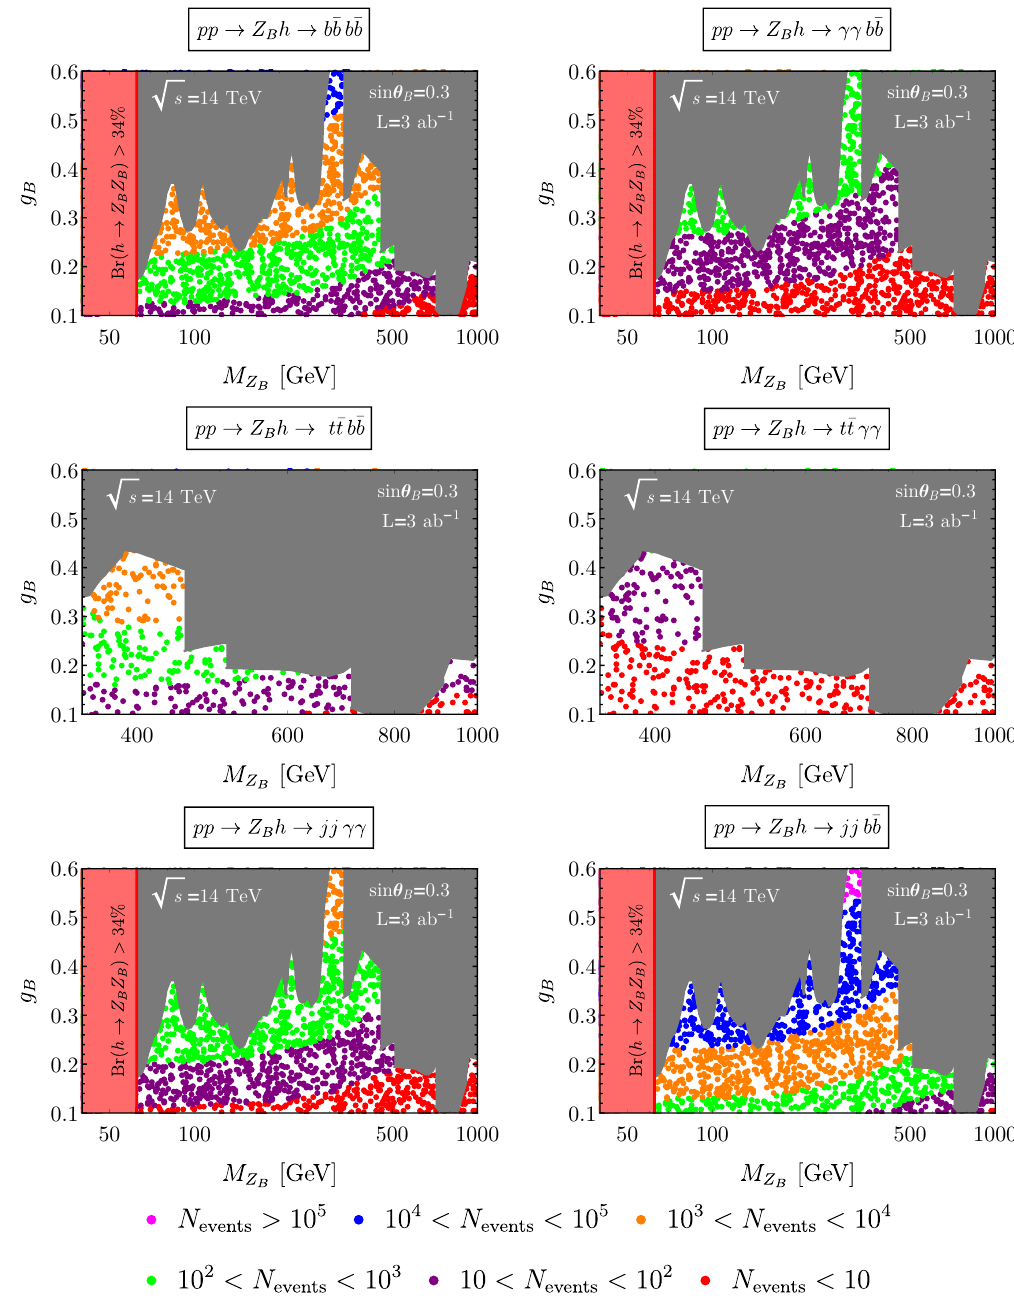
Figure 9 . Predictions for the number of events at the LHC with center-of-mass energy of 14 TeV assuming that the integrated luminosity is = 3000 fb (cid:0) 1 and using the maximal allowed value for L the mixing angle sin (cid:18) B = 0 : 3. We show the number of events for the most relevant channels: (cid:13)(cid:13) t (cid:22) t , (cid:13)(cid:13) b (cid:22) b , (cid:13)(cid:13) jj , b (cid:22) bb (cid:22) b , b (cid:22) bt (cid:22) t , and b (cid:22) bjj . The gray region is excluded by the LHC bounds, while the red region is excluded by the bound on the branching ratio of the new Higgs decays.